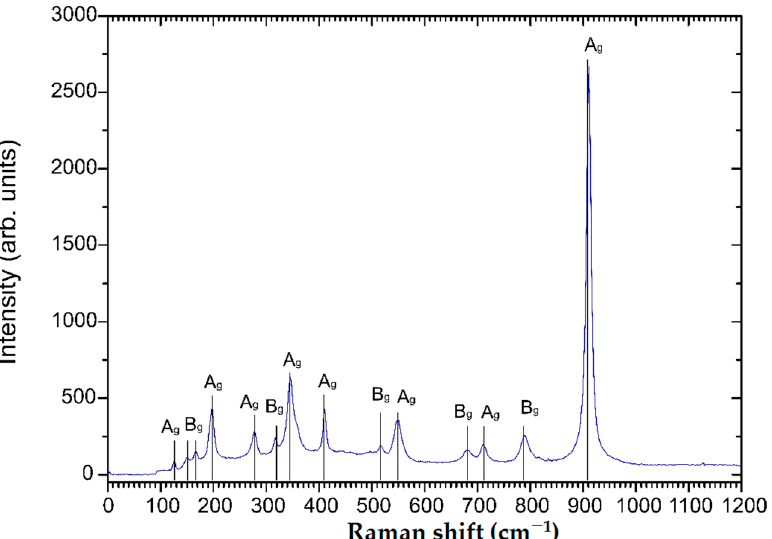
Table 1. Surface stoichiometry amorphous and monoclinic ZnWO 4.